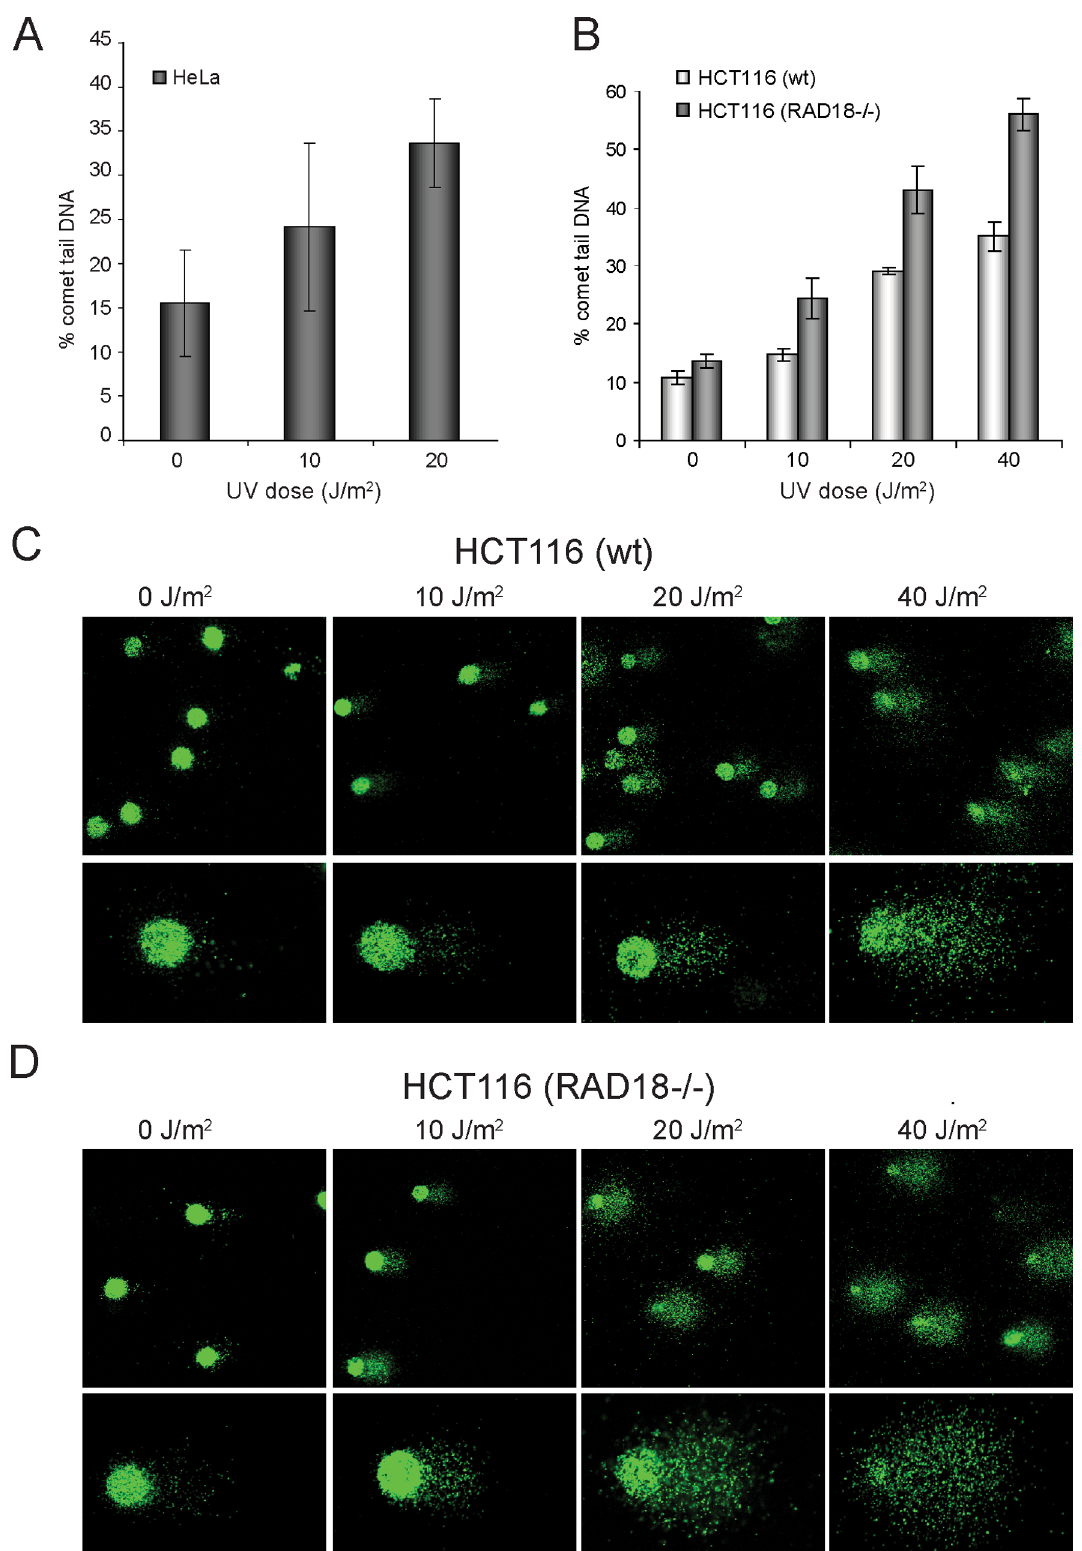
Figure 4. Dose dependent inhibition of replication progression caused by UV as detected by BrdU comet PRR assay. Cells were BrdU pulse labelled and mock treated or irradiated with UV and replication fork progression was followed by alkaline BrdU comet PRR assay. BrdU was detected by immunostaining, and quantitative measurement of comet tail DNA was done by Komet5 software. The % comet tail DNA, as a measure of discontinuity was illustrated. ( A ) Dose-effect curve of HeLa cells after 4 h recovery time. ( B ) Dose-effect curve of HCT116(wt), HCT116(Rad18 2 /